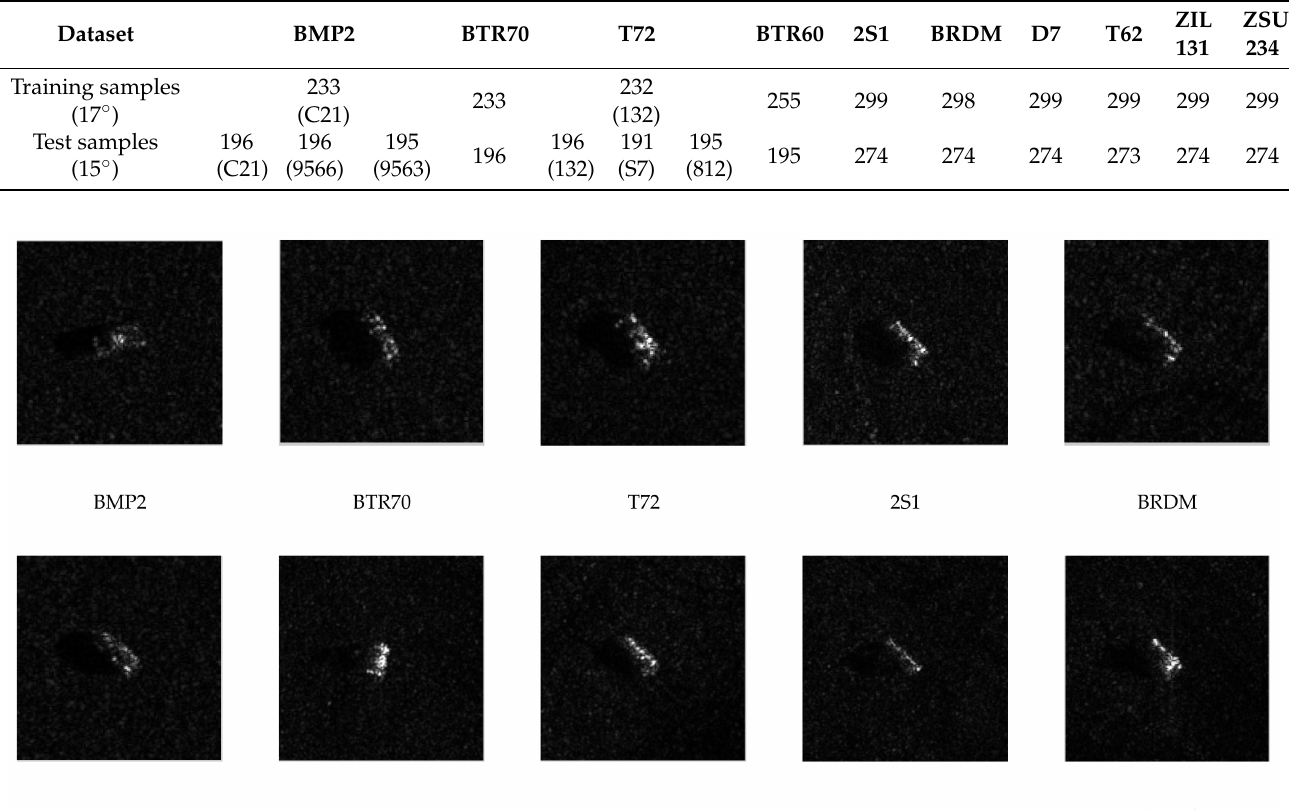
Table 3. Details of Training and Test Samples for the Ten-Target Dataset.